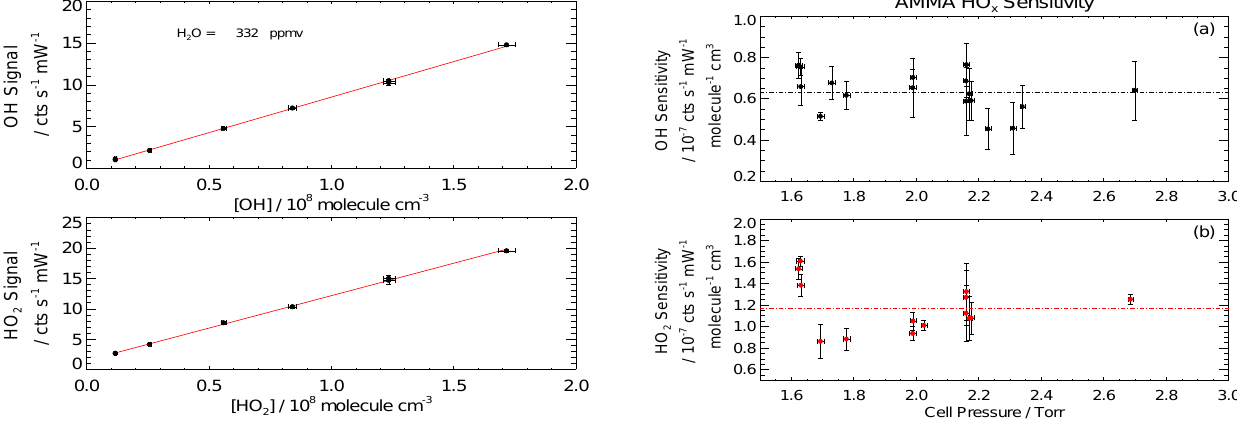
Fig. 6. Instrument Sensitivity as a function of fluores- cence cell pressure for OH (a) and HO 2 (b) . During AMMA, the cell pressure varied between 1.5Torr (9km alti- tude) and 2.1Torr (sea level). The dashed line indicates the mean sensitivity used for the AMMA dataset ( C OH =